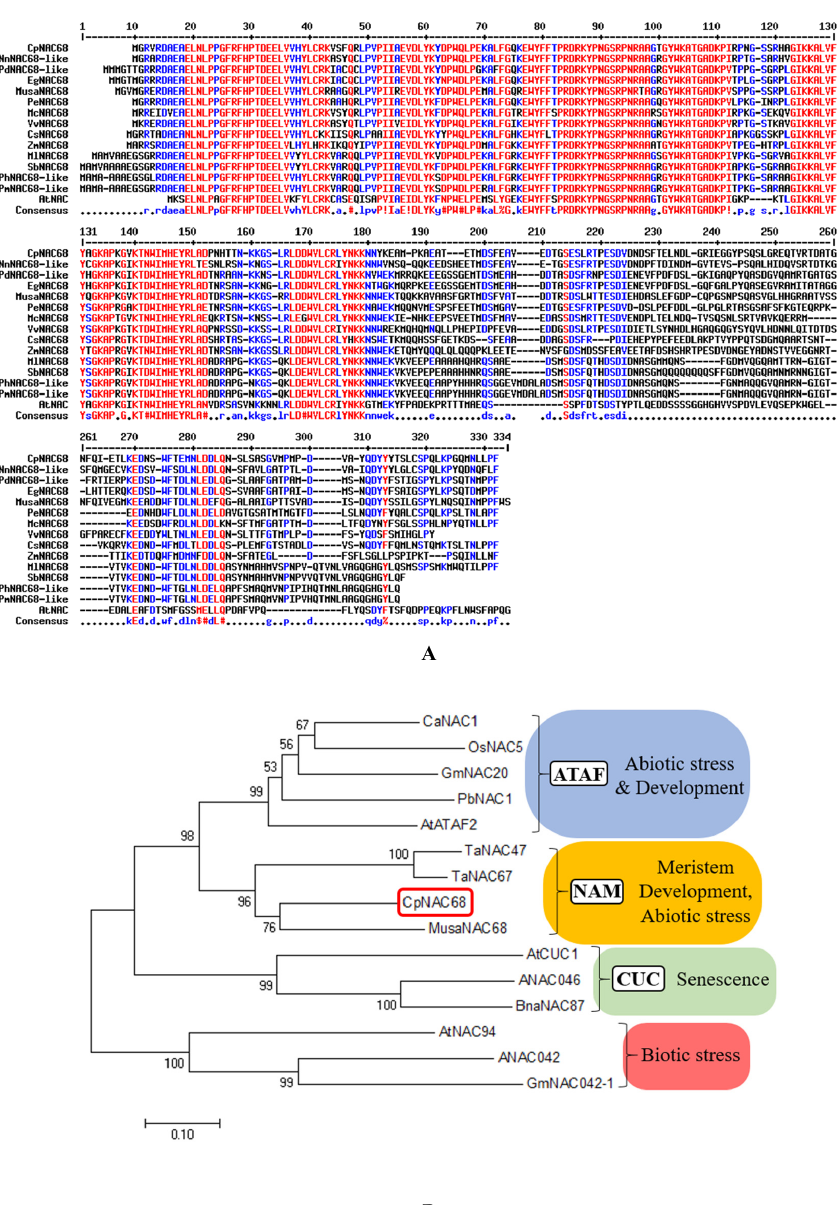
Figure 1. Sequence analysis of CpNAC68 . ( A ) Multiple sequence alignment of CpNAC68 with other NAC68 TFs. The red sequence shows highly conserved subdomains. ( B ) Cluster analysis of CpNAC68 (indicated by a red frame) and NAC pro- teins from other species. Accession numbers: Nelumbo nucifera (XP_010257746.1), Phoenix dactylifer (XP_008782755.1), Elaeis guineensis (XP_010921285.1), Musa acuminata (XP_009399922.1), Phalaenopsis equestris (XP_020578930.1), Macleaya cordata (OVA03901.1), Vitis vinifera (XP_002283807.1), Crocus sativus (ABU40779.1), Zostera marina (KMZ65511.1), Miscanthus lutarior- iparius (AIS74871.1), Sorghum bicolor (XP_002458677.1), Panicum hallii (XP_025816775.1), Panicum miliaceum